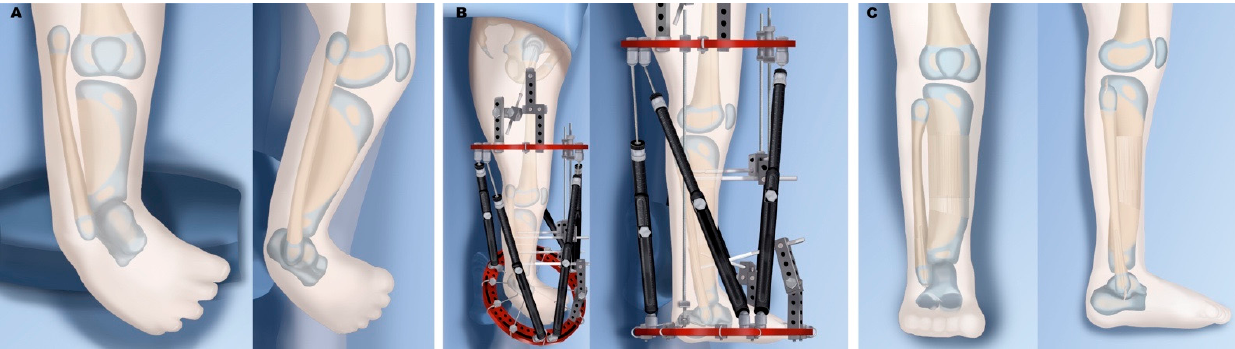
Figure 4. Treatment of Paley type 2B. ( A ) Bracket epiphysis deformity of tibia. ( B ) Application of external fixator after excision of bracket, with staged gradual foot correction, distal fibular transport, and tibial osteotomy for lengthening. ( C ) Results after completion. The foot has been corrected to a plantigrade position, the fibula is at station with a distal epiphysiodesis, and the tibia is longer due to lengthening.